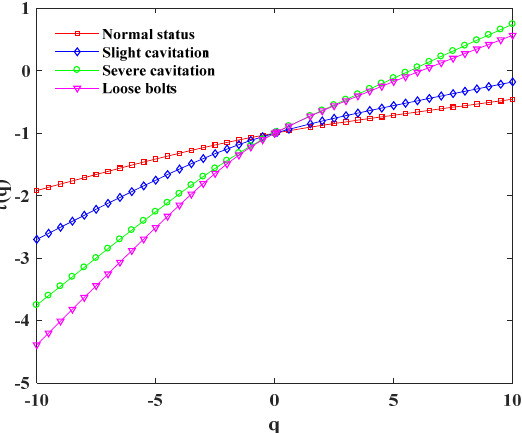
Figure 6. Quality index of vibration signal of centrifugal pump.